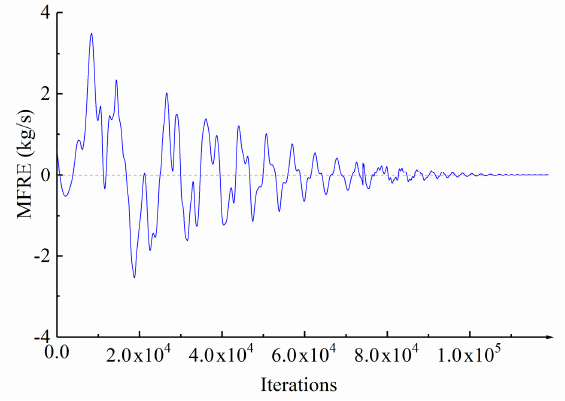
Figure 3. Mass flow rate error (MFRE) time-history curve. Table 2. MFRE values under different cases in steady state.